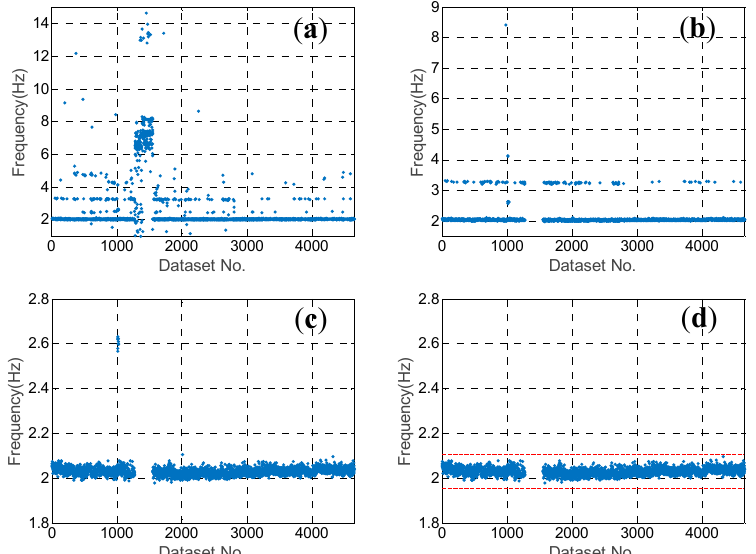
Figure 8. The results of the candidate mode of modal frequency 8.26 Hz at each step: ( a ) after the 1st step with the largest similarity coefficient in every dataset selected; ( b ) after the 2nd step with the ones with 0.8 MAC  left; ( c ) after the 3rd step with the MAC fulfilling the Tukey’s fence criterion; and ( d ) after the 4th step with the modal frequency fulfilling the Tukey’s fence criterion.